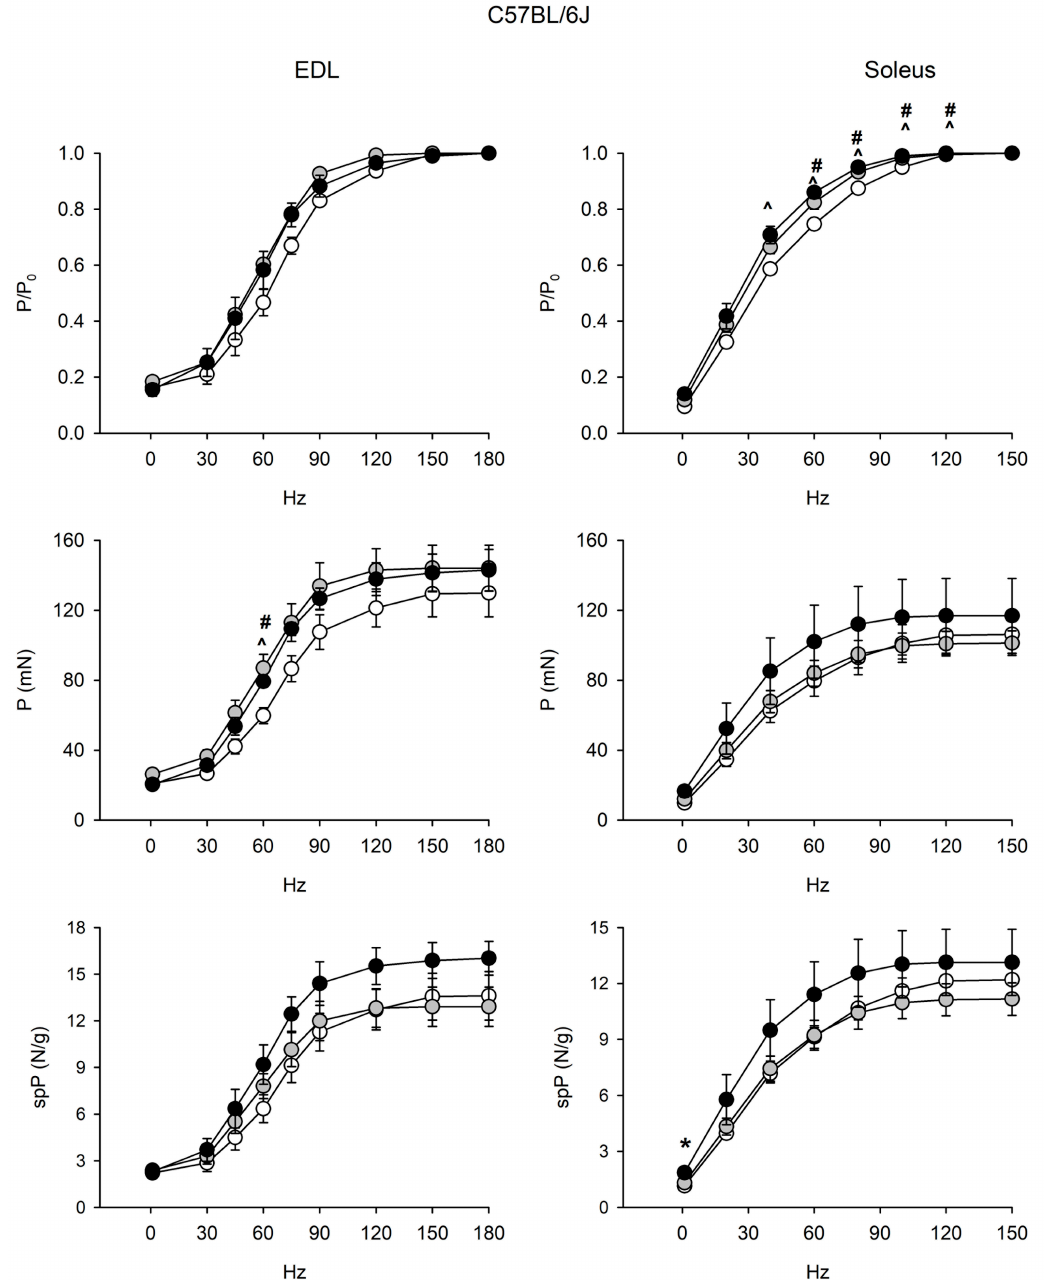
Figure 2. Force-frequency curves on adult (open circle), vehicle-treated old (gray circle) and curcumin-treated old (closed circle) EDL (left) and soleus (right) muscles of 6J mice. Muscles were stimulated at various frequencies under isometric conditions. Force is expressed as relative to the maximum tetanic force (top charts), as isometric absolute force (middle charts) and as specific tension (isometric absolute tension normalized to muscle wet weight) (bottom charts). Values are mean ± SEM. Significant difference (ANOVA and post-hoc p < 0.05) is indicated by * between old and curcumin-treated old, by # between adult and old, and by ˆ between adult and curcumin-treated old. EDL data were obtained from n = 3 adult mice; n = 3 old mice and n = 4 curcumin-treated old ones; soleus data were obtained from n = 6 adult mice; n = 7 old mice, and n = 5 curcumin-treated old